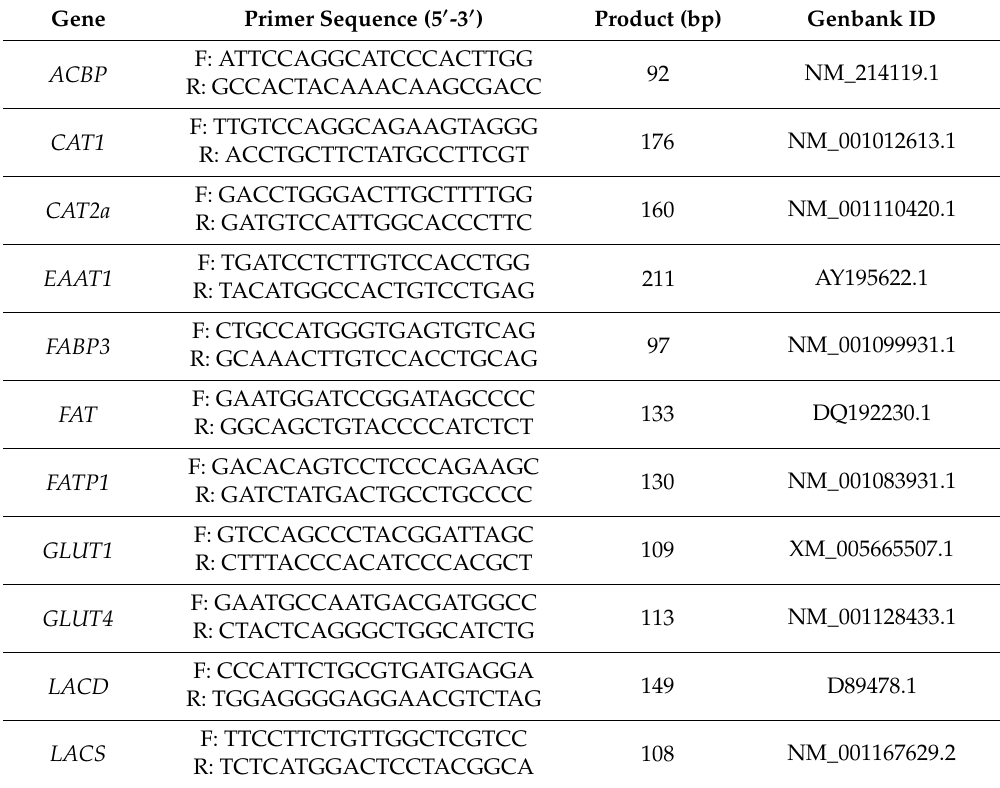
Table 1. Primer sequences of target and reference